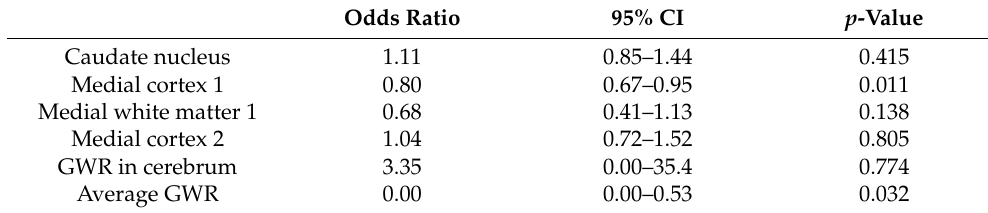
Table 3. Logistic regression of absolute attenuation in Hounsfield units and grey/white matter ratio.